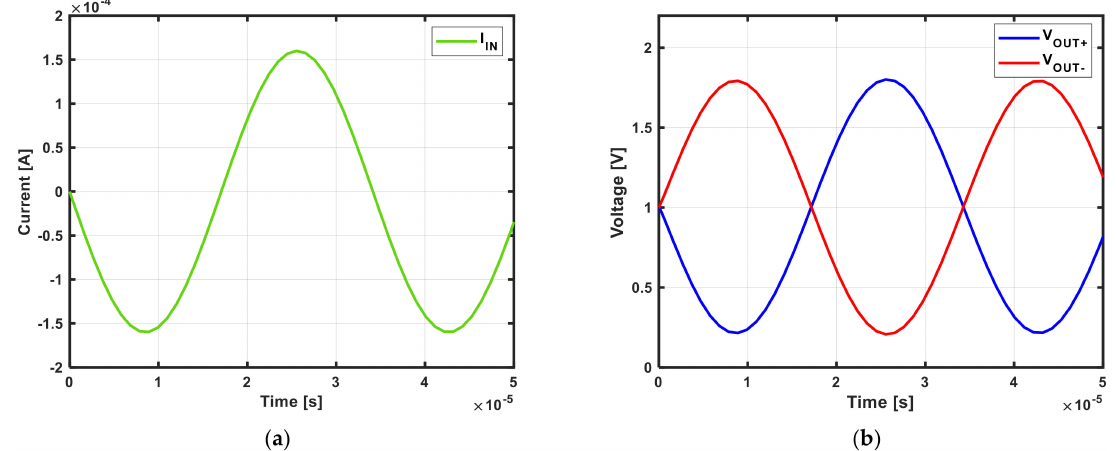
Figure 15. Simulated TIA transient response: ( a ) single-ended input current; ( b ) differential output